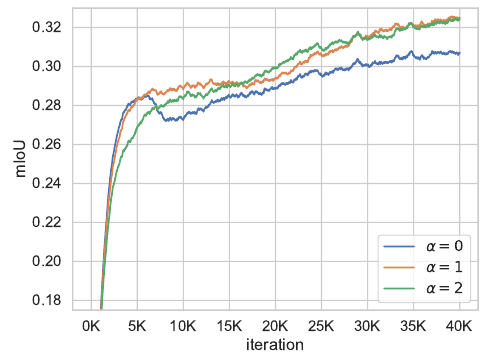
Figure 7. Ablation study showing the influence of the weight α for the loss term L incomp on mIoU during